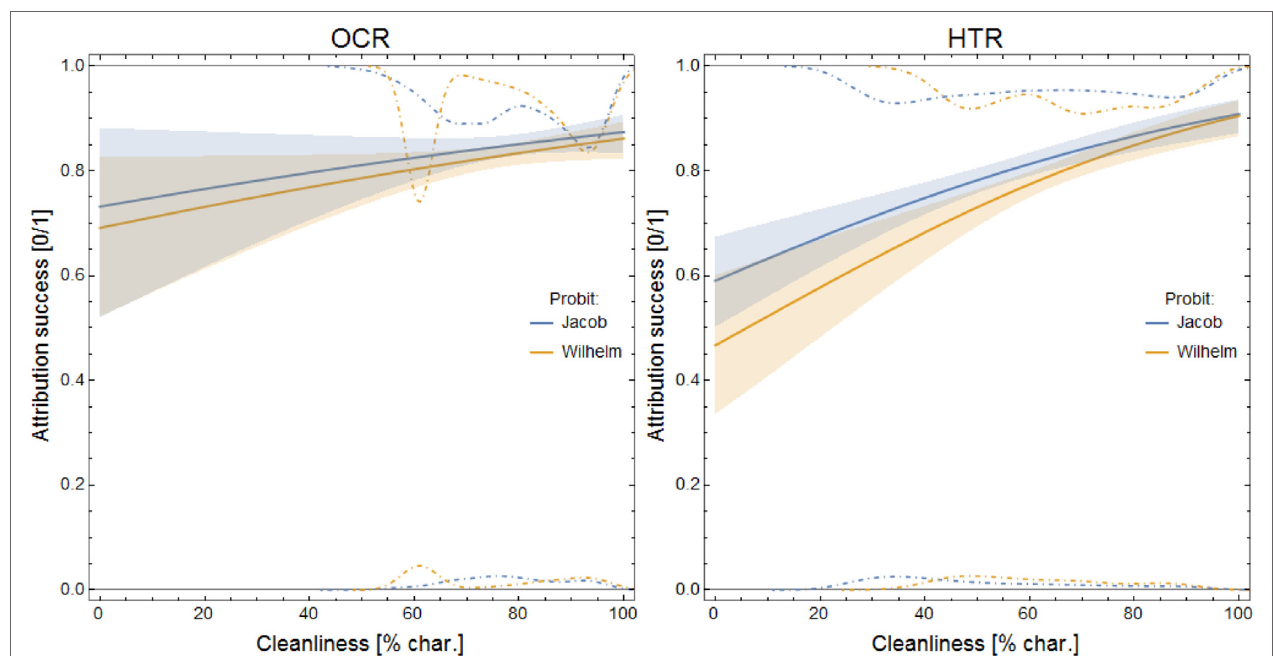
FigUre 12 | Probit models (continuous lines) fitted to randomly sampled texts; the shaded regions are 0.95 confidence boundaries. Dot-dashed lines indicate relative number of samples attributed: (top) correctly and (bottom) erroneously. Note that the upper histograms are upside down. For instance, in the OCR case, most of Wilhelm’s samples are 60 or 95% clean (peaks in the upper histogram), and at 60% cleanliness there are five times as many correct as incorrect attributions (upper relative to the lower peak